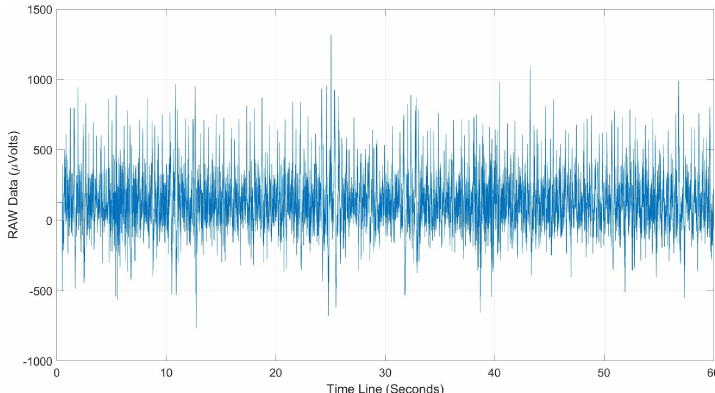
Figure 4. Human brain activity represented in a raw electroencephalogram (EEG)